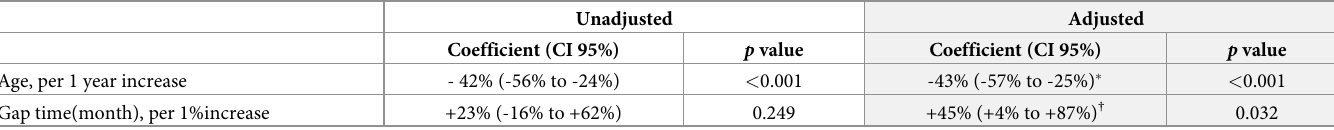
Table 2. Association between level of anti-HBs, age and gap time.